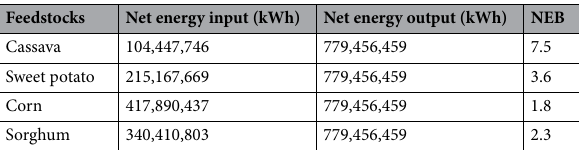
Table 8. Net energy balance (NEB) of the bioethanol feedstocks.